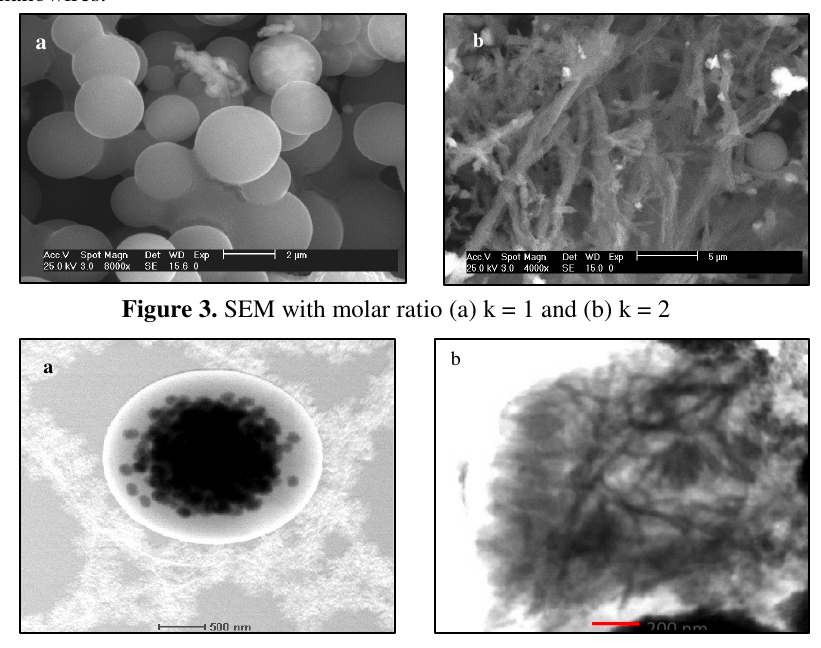
Figure 4. TEM micrographs of the material with molar ratio (a) k = 1 and (b) k =